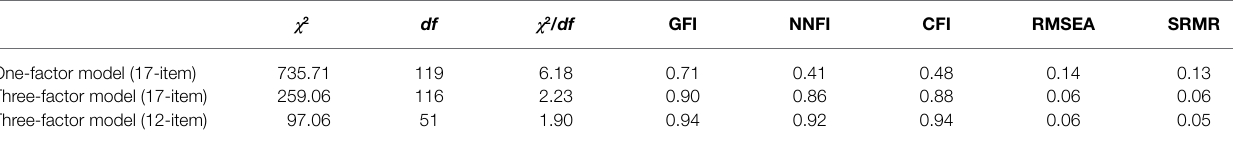
TABLE 2 | Confirmatory factor analysis and model comparisons (Sample 2, n =